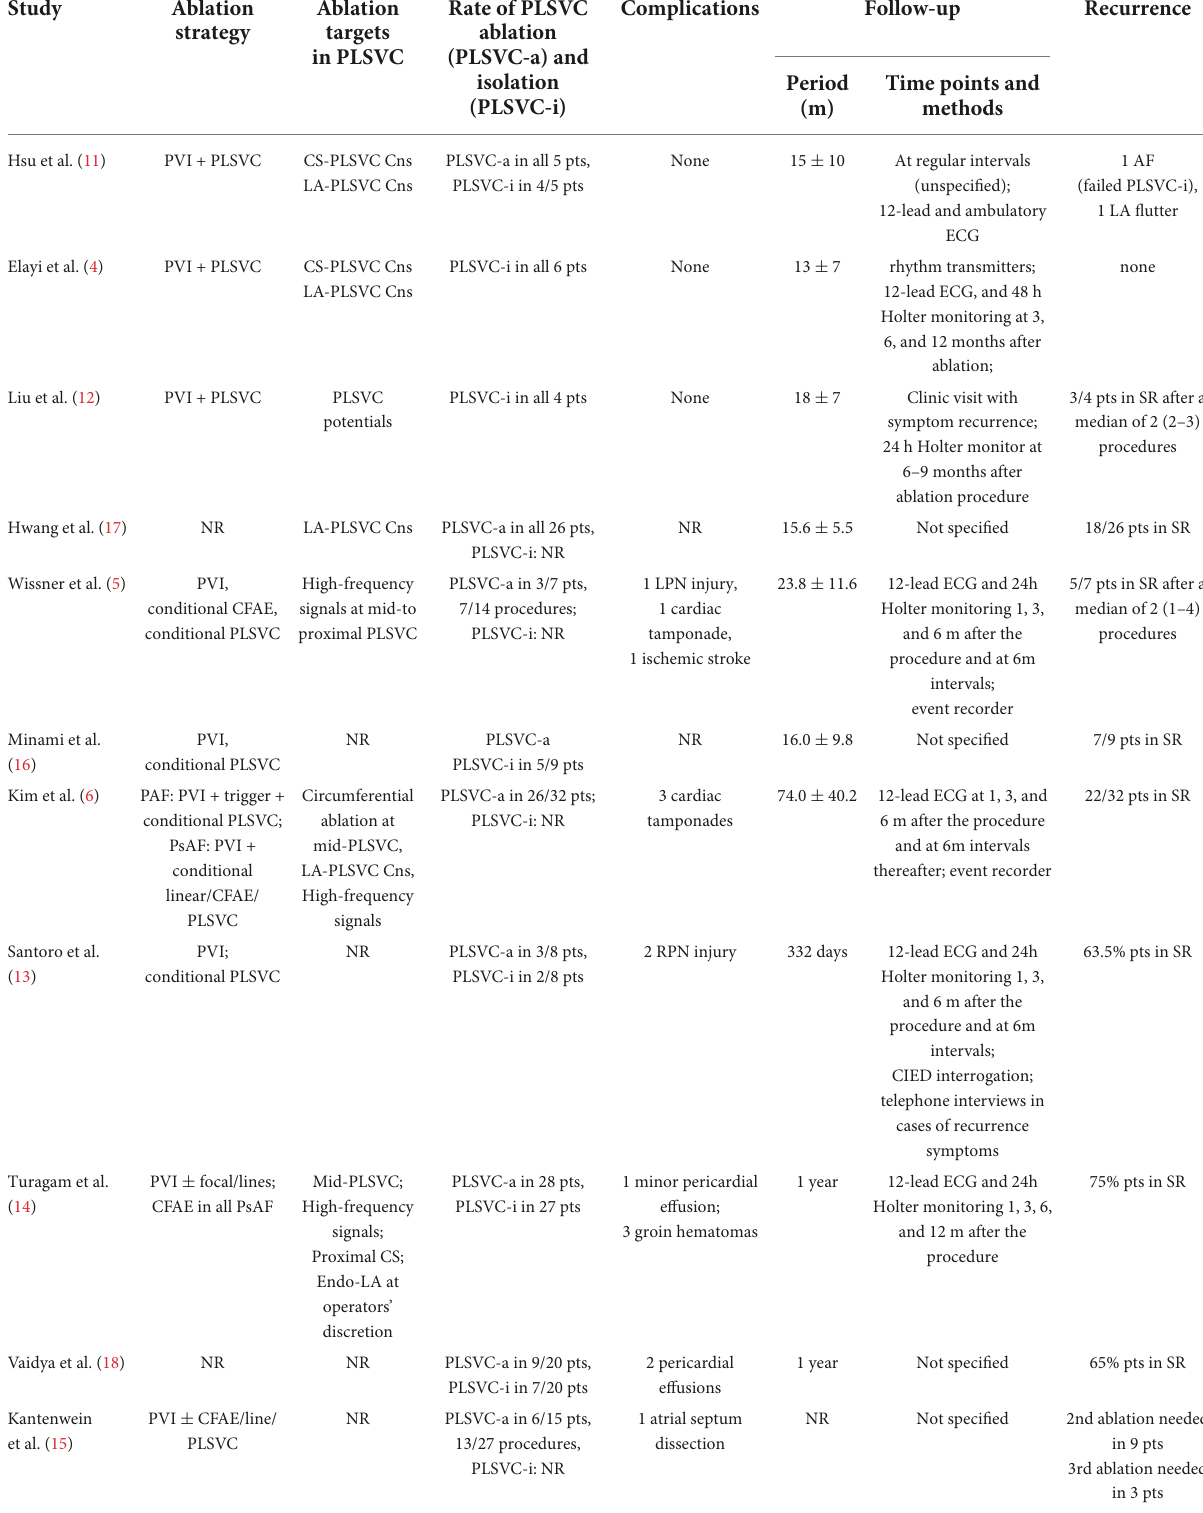
Abbreviationssameas Table1